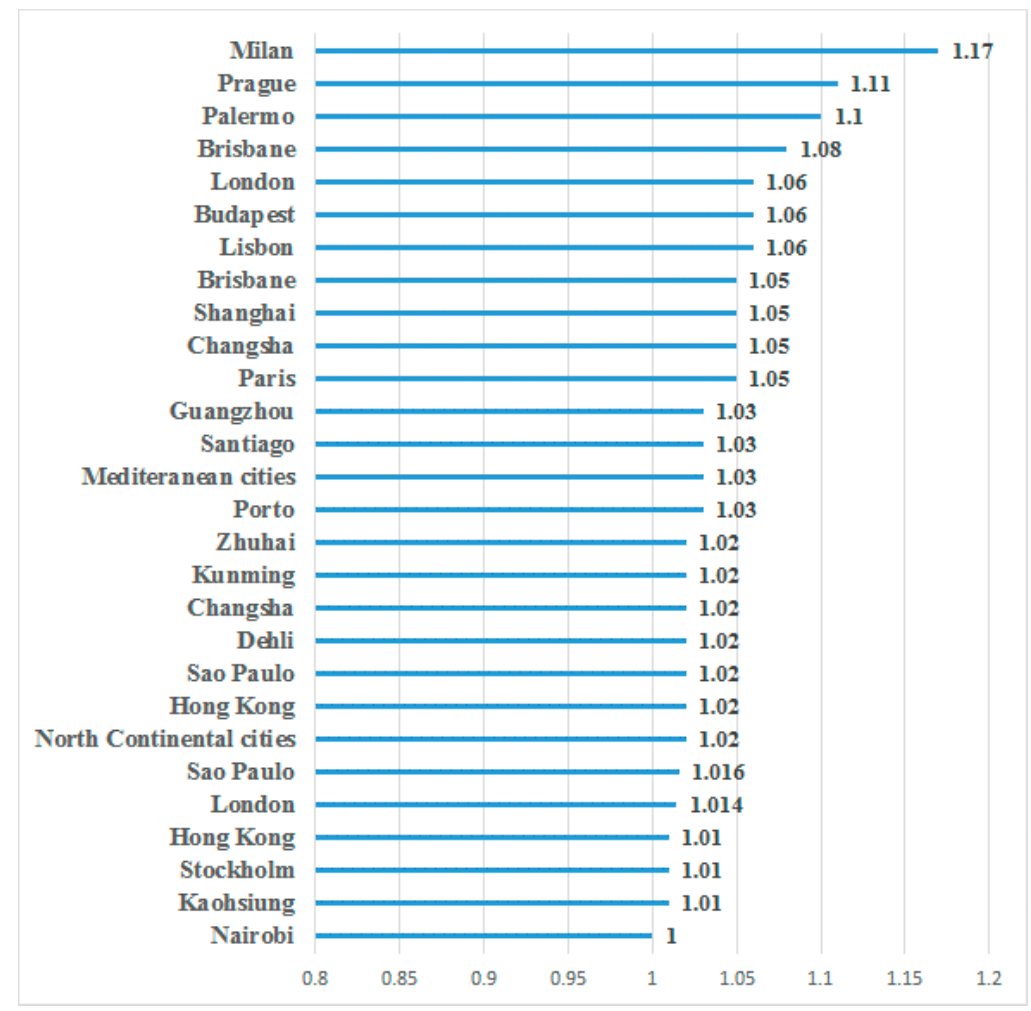
Figure A1. Relative risks (RR) for heat-related all-cause mortality studies conducted in large urban areas (Unit: RR per 1 °C increase; Data adopted from Benmarhnia et al., 2015 [24]).